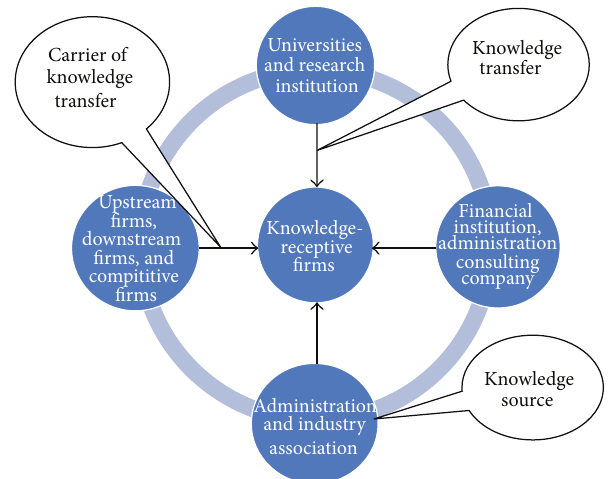
Figure 1: Flowchart of knowledge network sharing among cluster